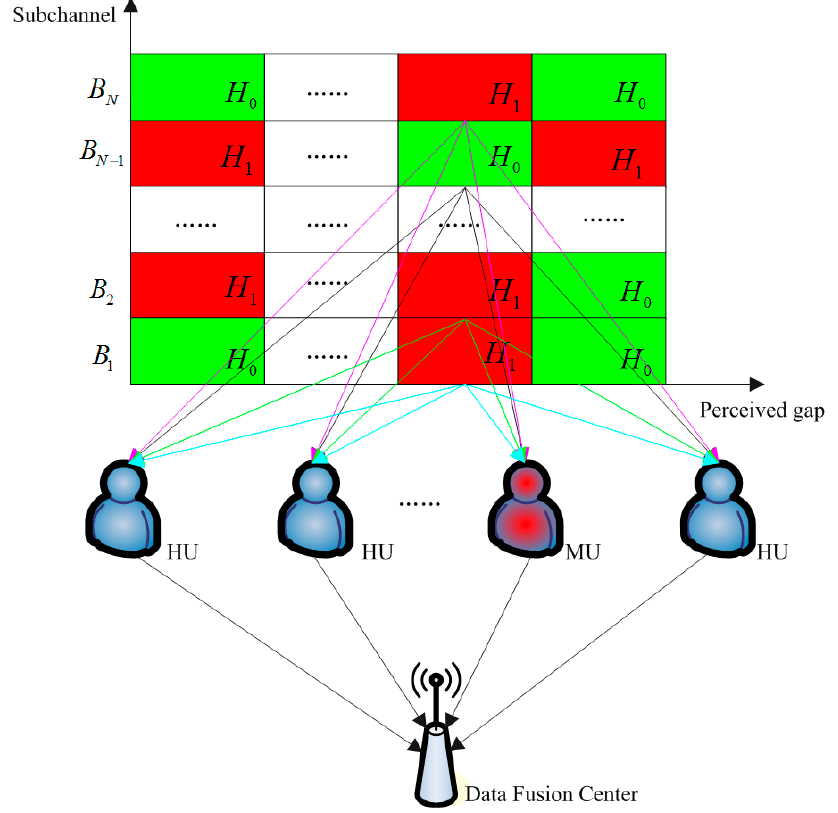
Figure 3. Multi-channel collaborative spectrum sensing system model based on β -reputation system.